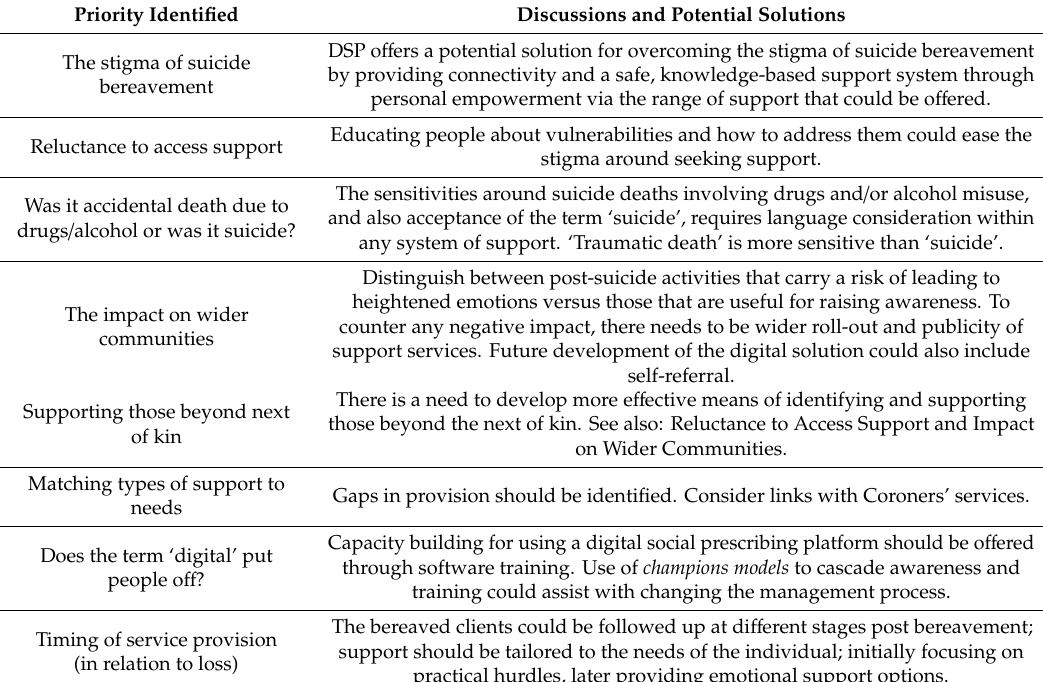
Table 1. Themes and priorities for enhancing postvention support after suicide identified in Step 2 and discussed in Step